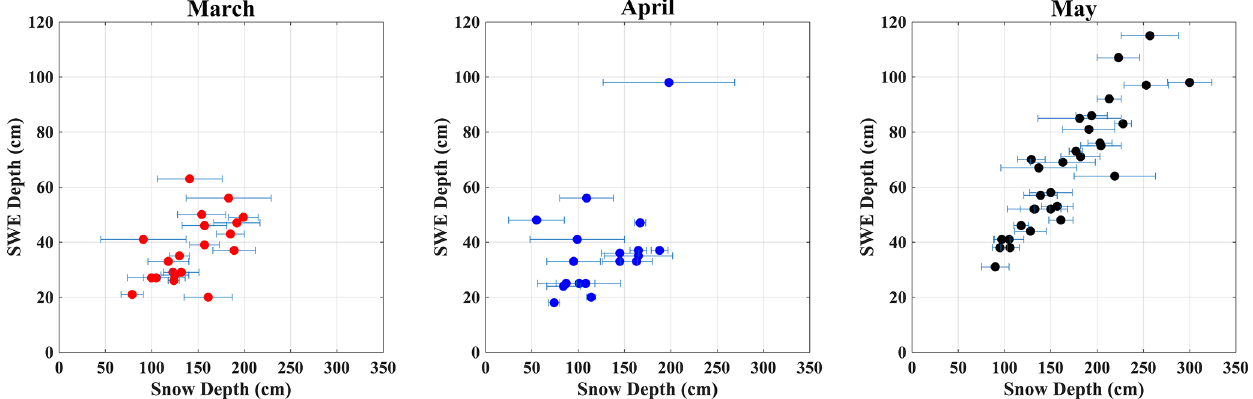
Figure 11. Fieldwork 2018 measurements by month. The 70 in situ snow water equivalent (SWE) measurements ( y axes) from 2018 are plotted by month, along with their co-located snow depth measurements ( x axes). The bars show the minimum, maximum, and average of each fieldwork site where eight snow depth measurements were obtained in a 100m 2